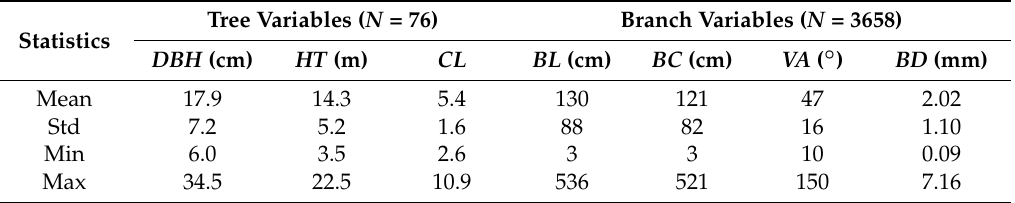
Table 2. Descriptive statistics of sample trees and all branches for 76 planted Pinus sylvestris var. mongolica